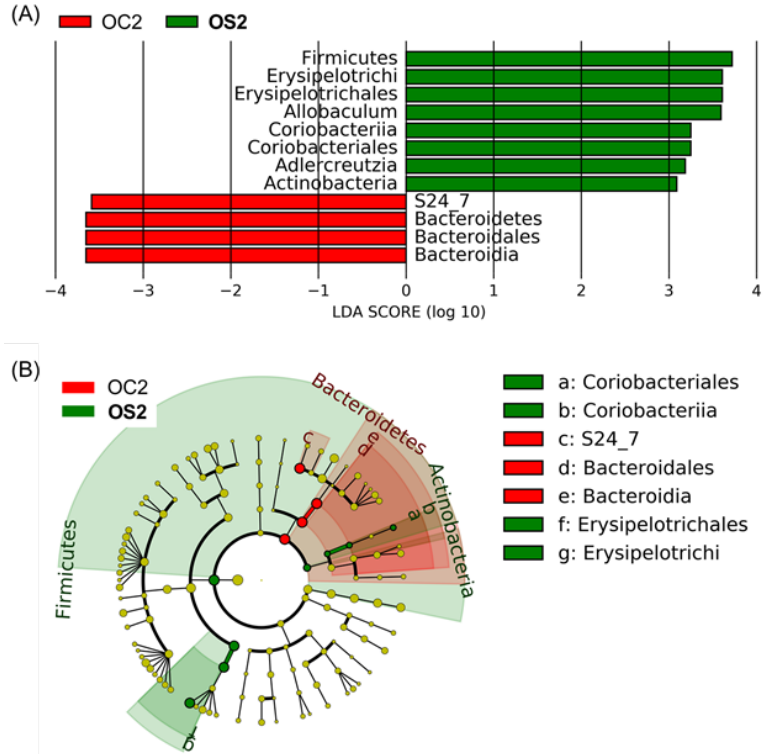
Figure 4. Identification of bacterial biomarkers between SFN-treated old mice ( OS2 ) and old control mice of the same age (OC2), using LEfSe analysis. ( A ) The distribution bar chart of LDA values shows the species with linear discriminant analysis (LDA) scores greater than 3 and the species with significantly different abundances in different groups. The length of the histogram represents the impact size of significantly different species. ( B ) The circle radiating from inside to outside represents the classification from the phylum to the genus level. Each small circle at different classification levels represents a sub-classification level. The diameter of the small circle is proportional to the relative abundance. Group notations are the same as in Figure 1. LDA scores < 0 indicate that corresponding features are enriched in OC2.